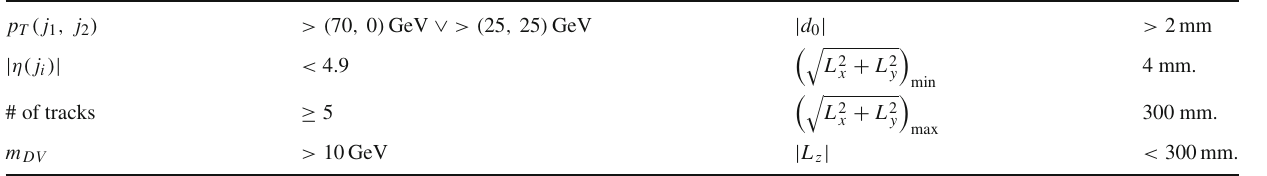
Table 3 Cuts for displaced jet